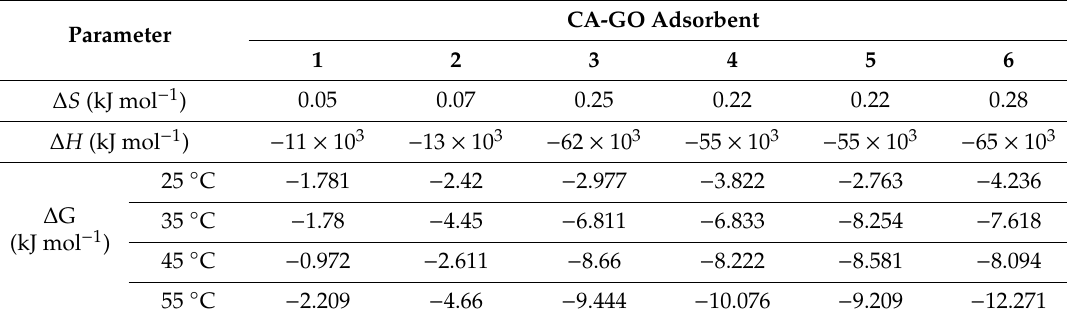
Table 4. Thermodynamic measurements for the adsorption of Ni 2 +